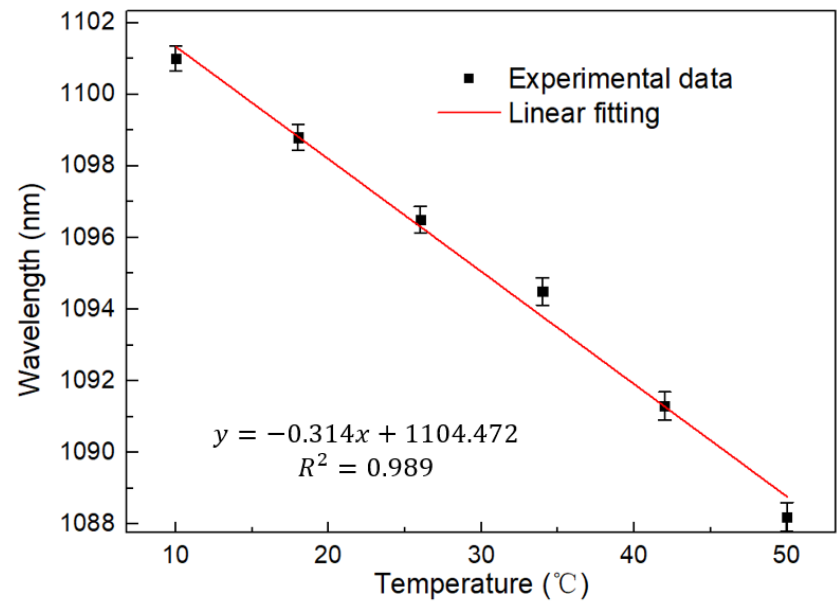
Figure 7. Linear regression curve of temperature with wavelength at BBS.